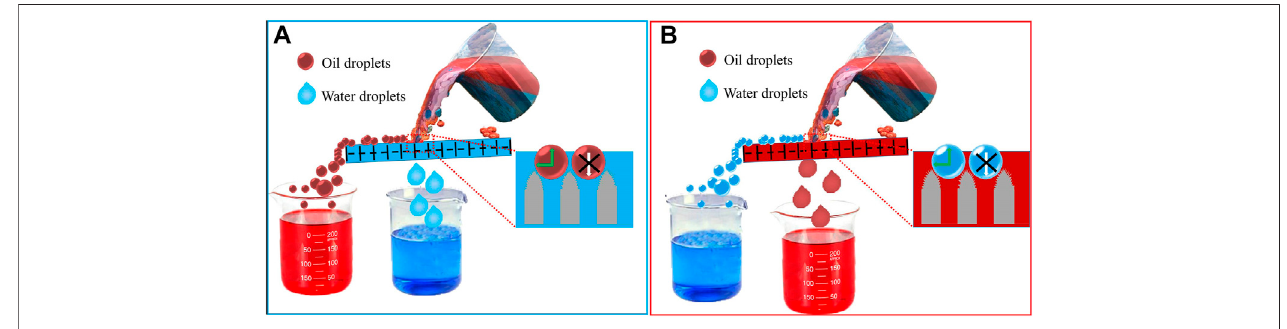
FIGURE 6 | Schematic of the possible mechanism of the as-prepared (LT, LCT, or LTCTO) copper mesh for oil-water separation.